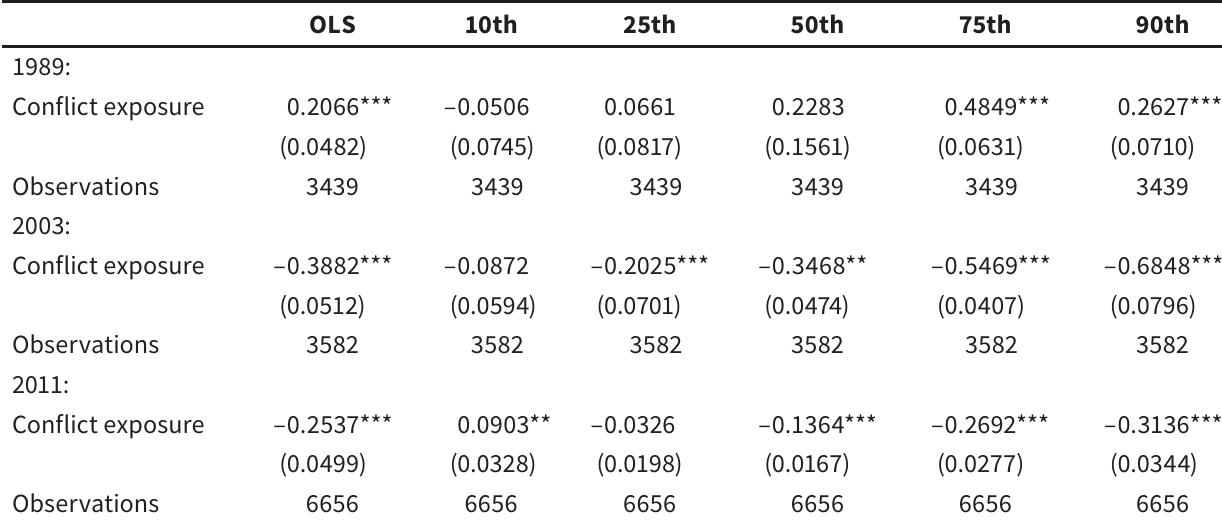
Table A2.11 Quantile Treatment Effects on the Treated using Log Household Expenditure – Conflict Exposure (without Freetown) OLS 10th 25th 50th 75th 90th